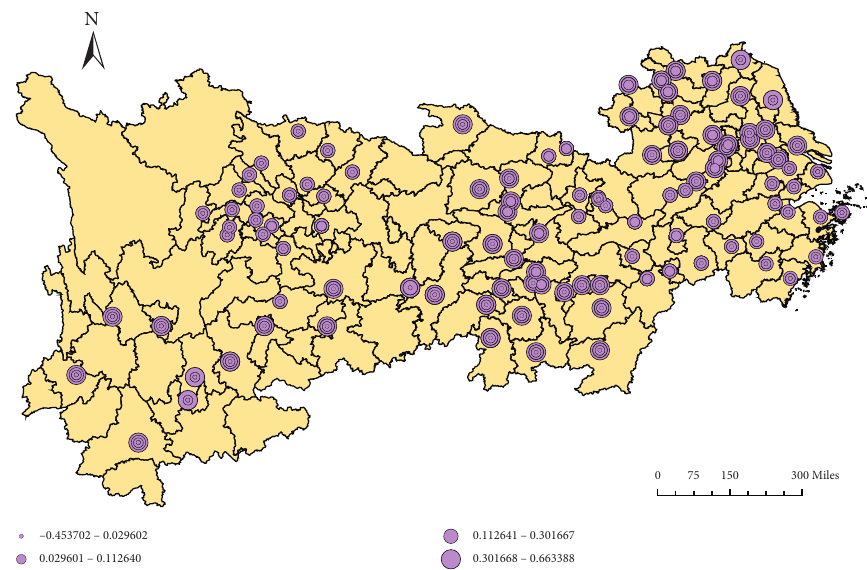
Figure 4: Spatiotemporal distribution map of the living